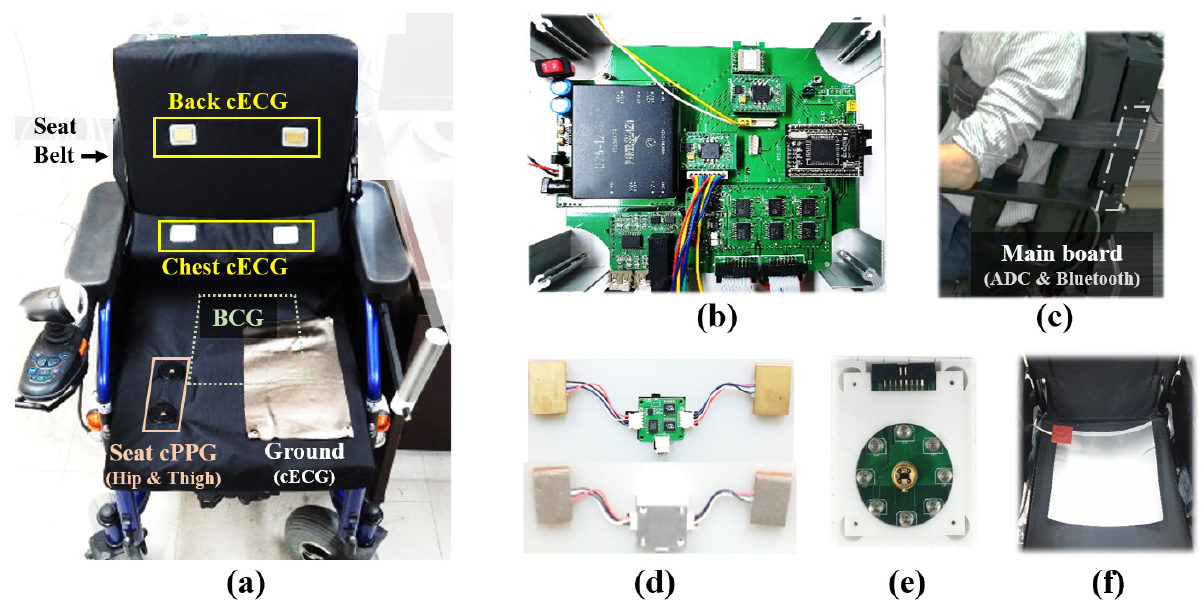
Figure 2. Biosignal chair. ( a ) Sensor locations. ( b ) Mainboard. ( c ) Side view of the wheelchair fastening seatbelt. ( d ) cECG electrodes with the casing used for the signal enhancement circuit. ( e ) cPPG probe with 8 LEDs and a PD. ( f ) EMFi sensor below the seat base for BCG detection.